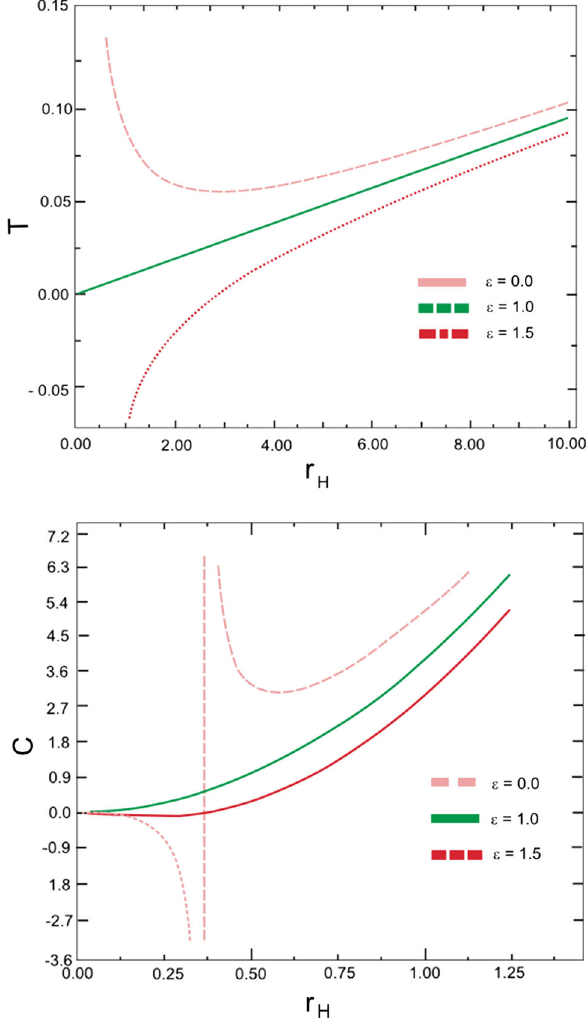
Fig. 7 Graphs of the temperature T × r H upper panel and the specific heat capacity (lower panel) considering the AdS 4 case. In the upper for N = 0 and L =